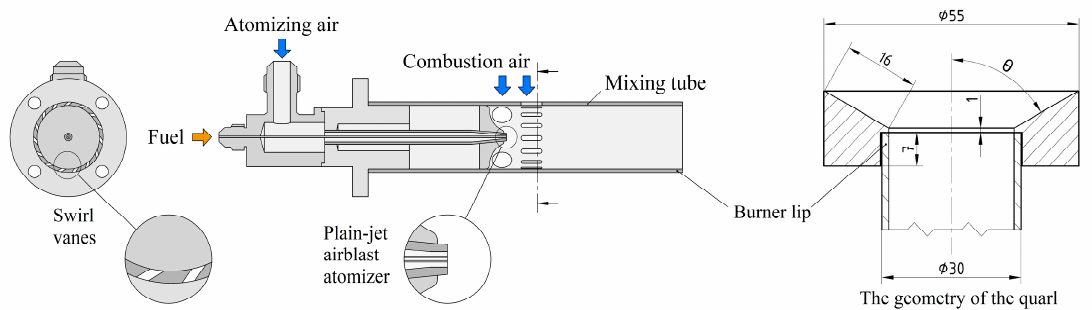
Figure 2. Cross-section of the burner and the quarl.